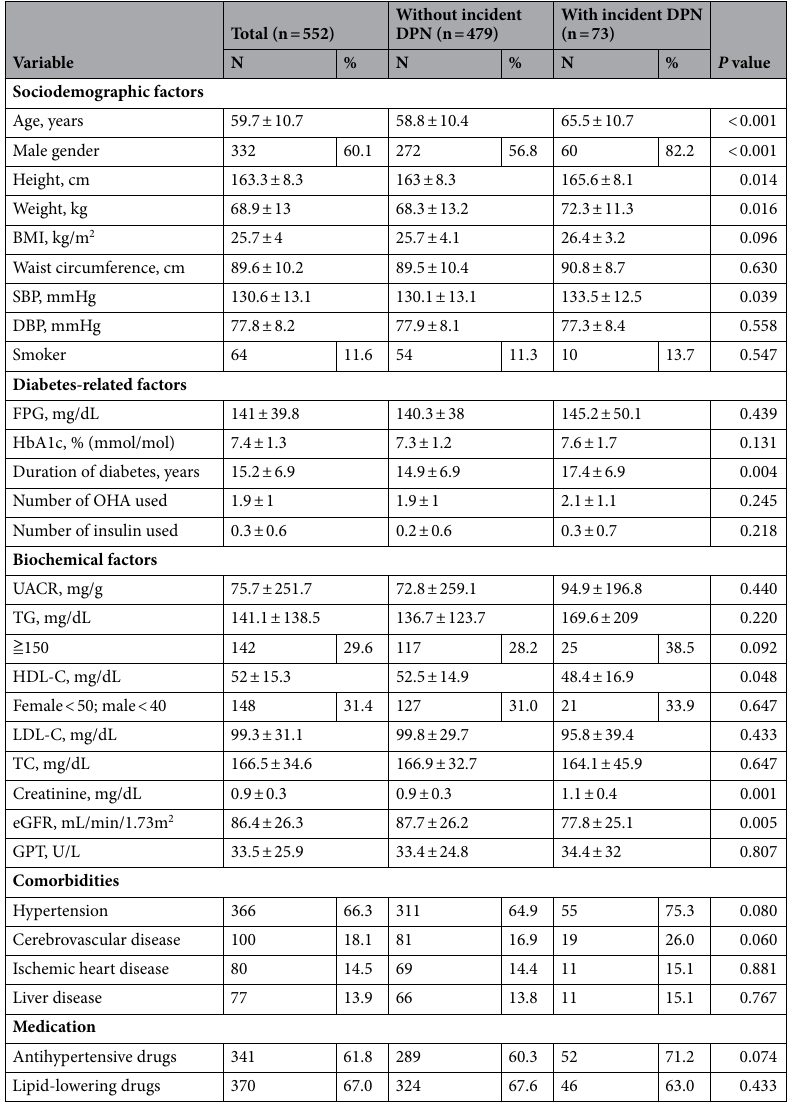
Table 1. Baseline characteristics of participants in our study. Data are expressed as mean ± SD for continuous variables and frequency (%) for categorical variables. Differences in continuous variables by independent t-test or paired t-test; differences in categorical variables by Fisher’s exact or chi-squared test. BMI body mass index, kg kilograms, cm centimeters, SBP systolic blood pressure, DBP diastolic blood pressure, FPG fasting plasma glucose, HbA1c glycated hemoglobin, OHA oral hypoglycemic agent, UACR urine albumin-creatinine ratio, TG triglyceride, HDL-C high-density lipoprotein cholesterol, LDL-C low-density lipoprotein cholesterol, TC total cholesterol, eGFR estimated glomerular filtration rate, GPT alanine